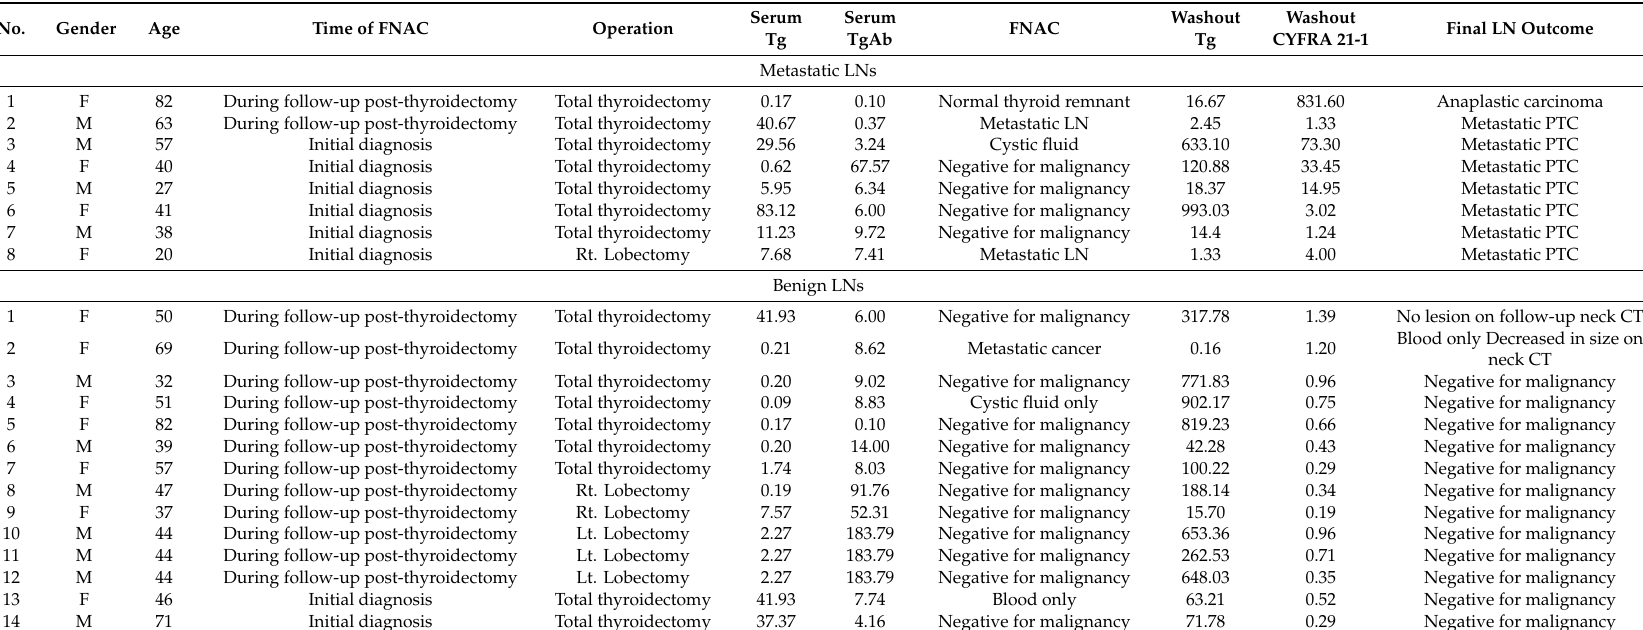
Table 4. The clinical characteristics of 22 LNs with discordant results between FNAC and washout